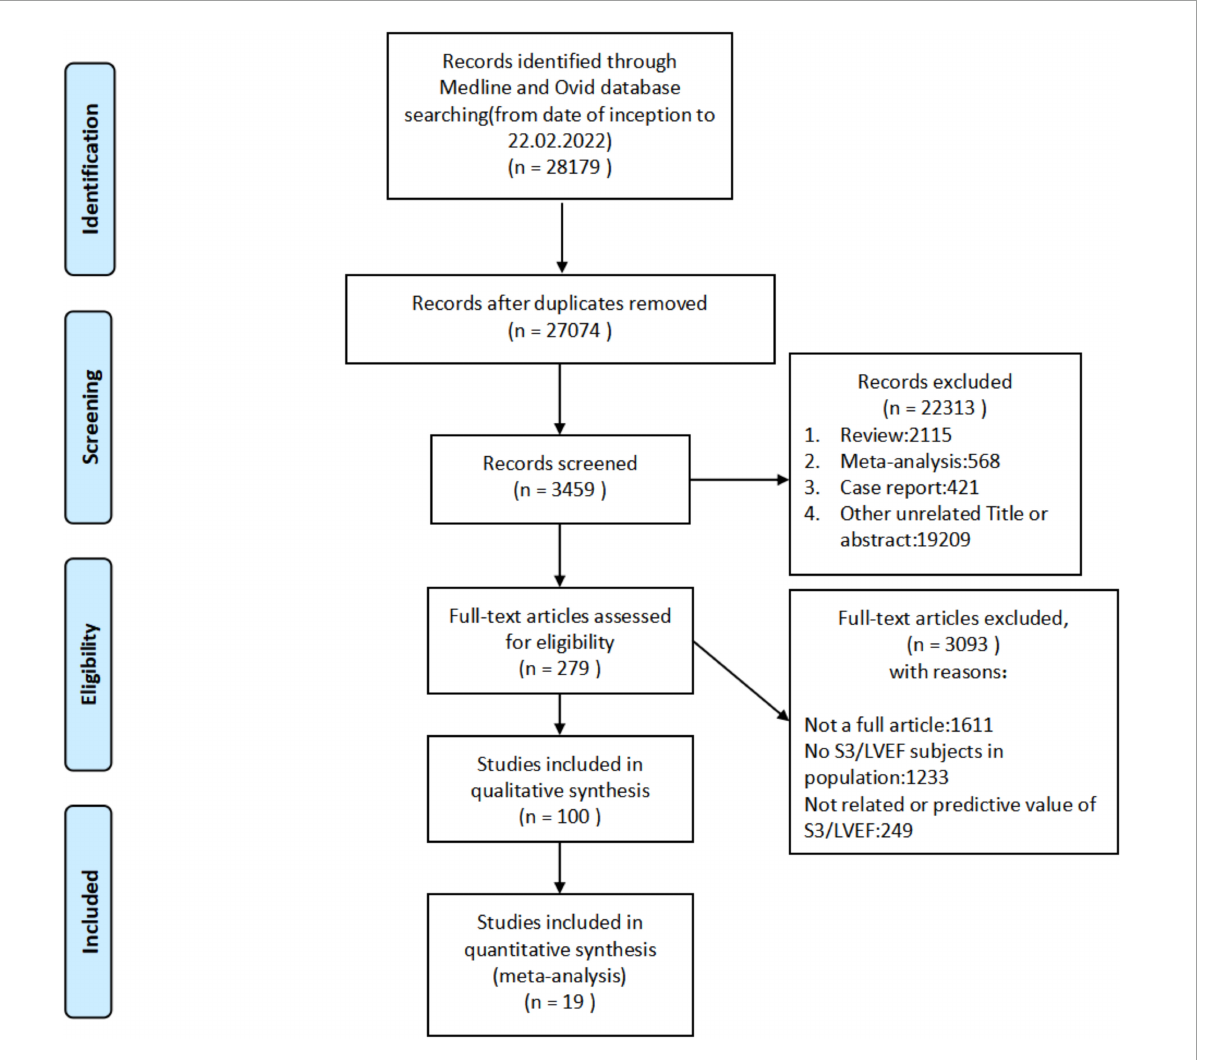
FIGURE1 Literature screening process of the